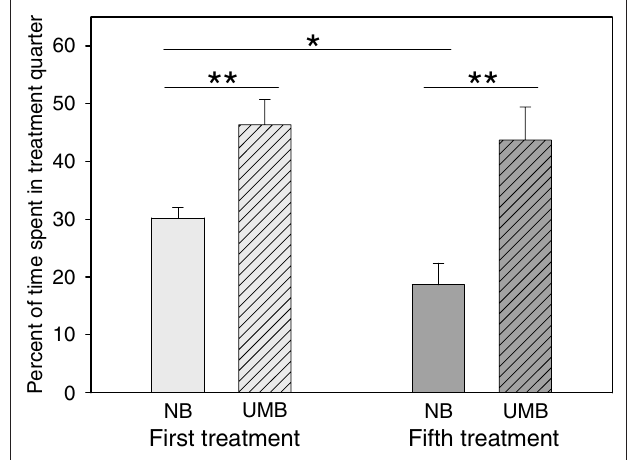
FIGURE 1 | Time spent in treatment quarter. NB, neutral bedding; UMB, unfamiliar male bedding. Data are shown as mean + SEM. Statistics: repeated measures ANOVA; there was a signifi cant main effect of treatment ( P < 0.0001) and time of treatment ( P = 0.046); post hoc testing: Bonferroni corrected paired samples t -tests: ** P < 0.01, * P < 0.05. Data were obtained from 10 NB mothers and 9 UMB mothers.